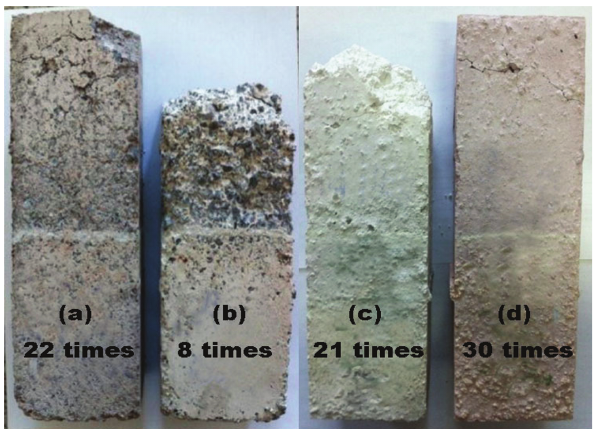
Figure 7: Comparison of thermal shock resistance tests: (a) and (d) are MgAl 2 O 4 spinel prepared from chromium slag and (b) and (c) are traditional MgAl 2 O